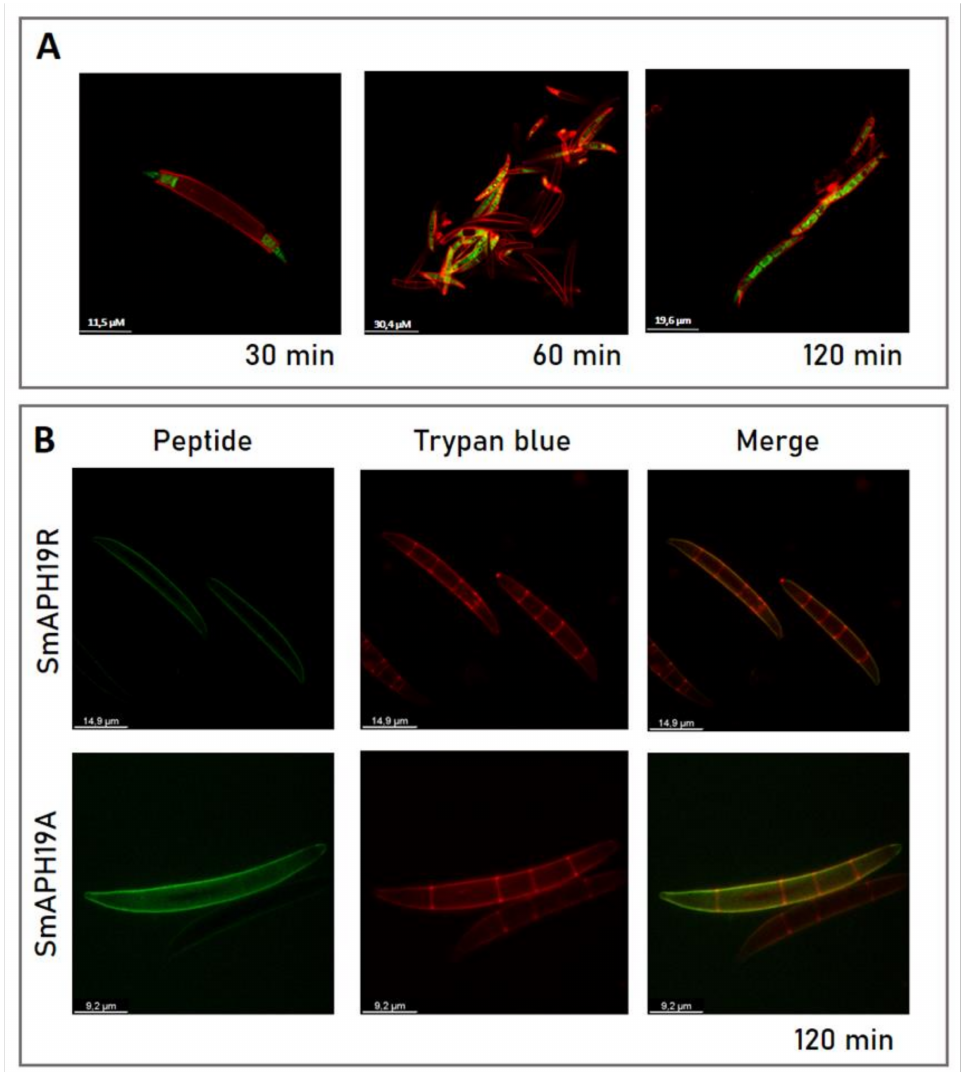
Figure 9. ( A ) Subcellular localization of SmAP α 1-21 peptide in Fusarium graminearum conidia incu- bated at MIC for indicated periods of time. ( B ) SmAP2H19R and SmAP2H19A at their MIC for 2 h. Bright-field, fluorescence, and merged images are shown as different columns. Resulting images of superimposition of the green (peptide) and red (cell-wall marker: trypan blue 10 µ g/mL, λ ex 633 and λ em 533–700 nm) channels are observed. Peptides were derivatized with fluorescein ( λ ex 488 nm and λ em 506–566 nm). Bar indicates size in µ m. Confocal fluorescence images are